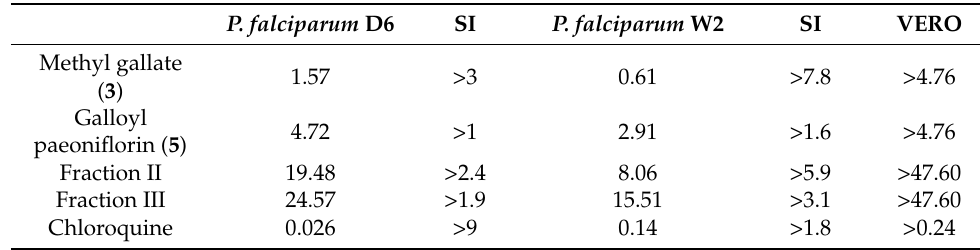
Table 2. IC 50 ( µ g/mL) of the antiplasmodial activity of fractions and isolated compounds from P. officinalis .